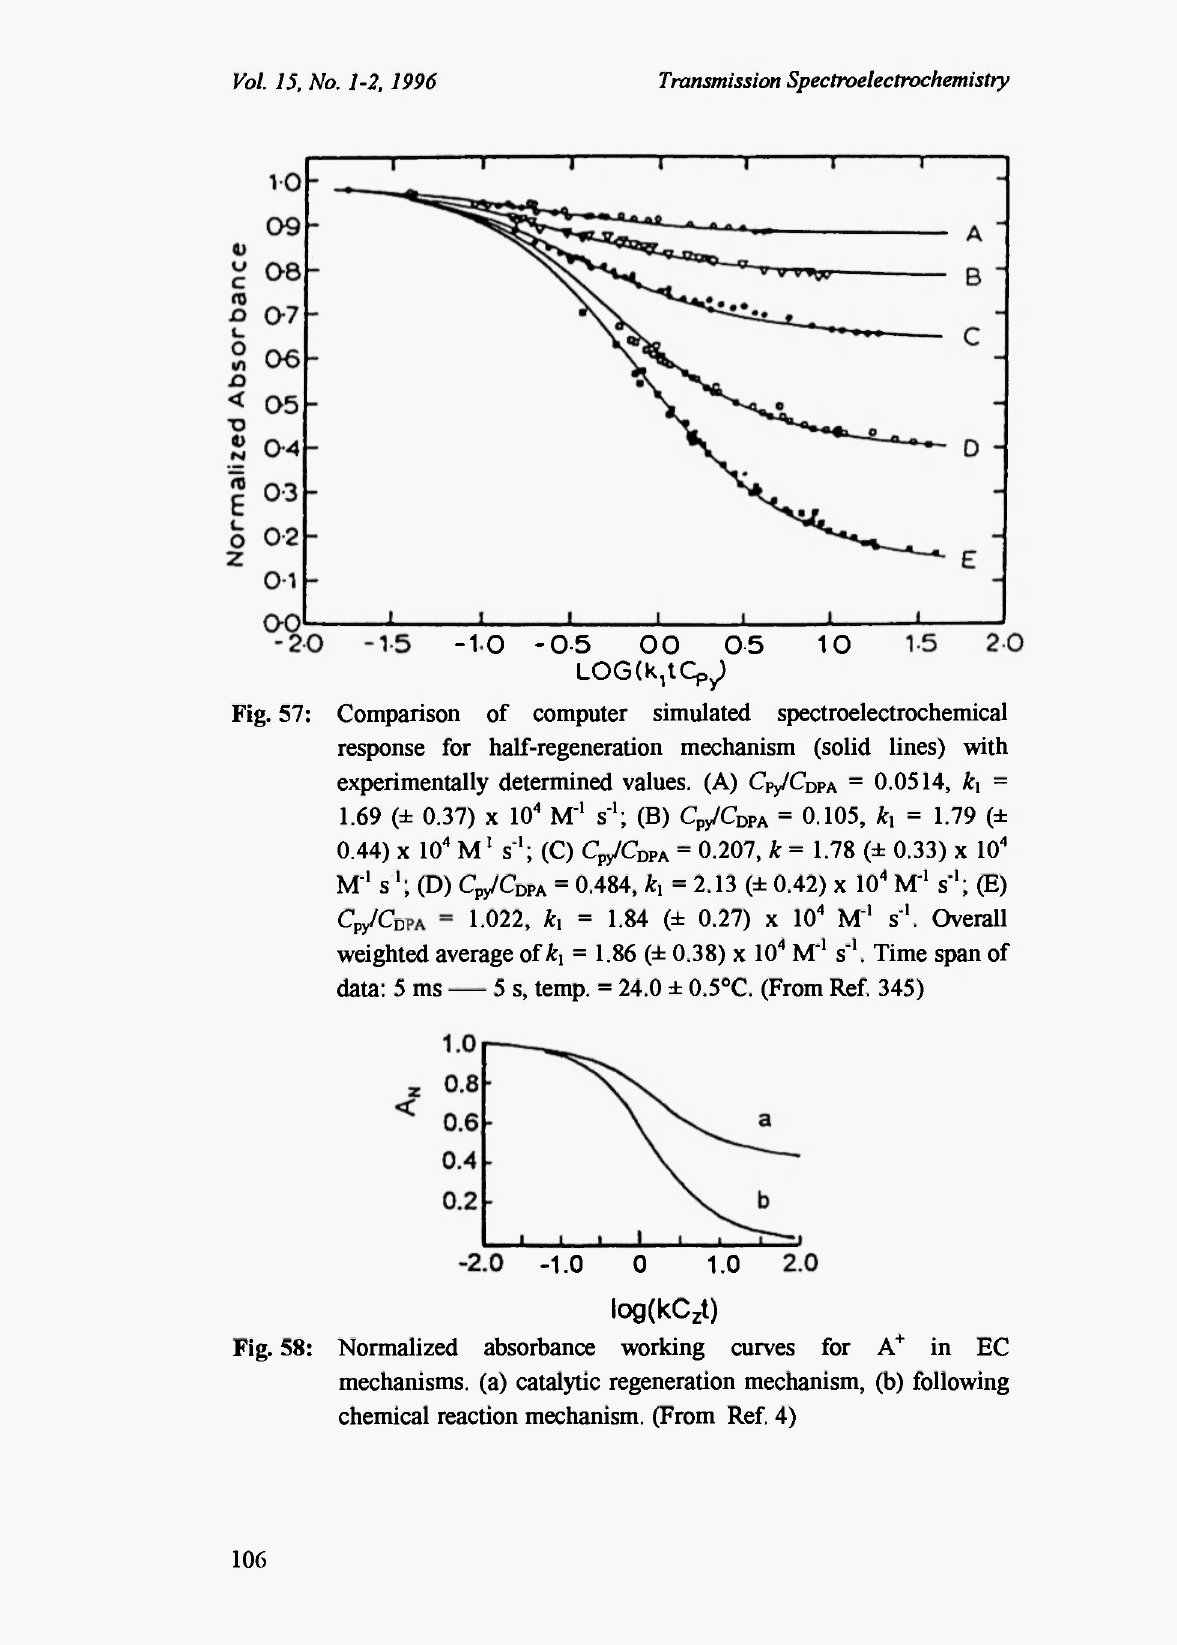
Fig. 57: Comparison of computer simulated spectroelectrochemical response for half-regeneration mechanism (solid lines) with experimentally determined values. (A) Cpy/C 1.69 (± 0.37) χ 10 4 M" 1 s" 1 ; (B) C